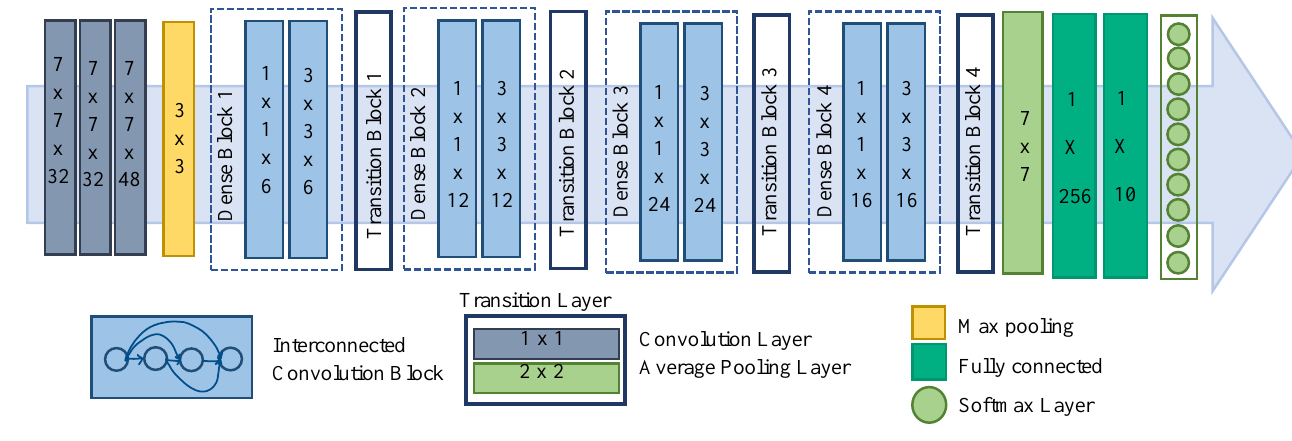
Fig. 6. DenseNet 121